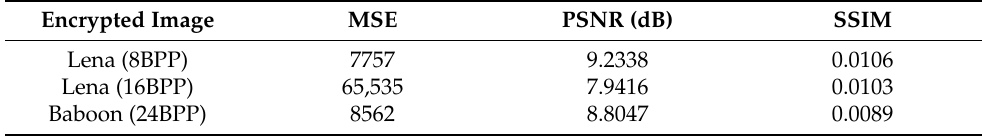
Table 16. Encryption quality